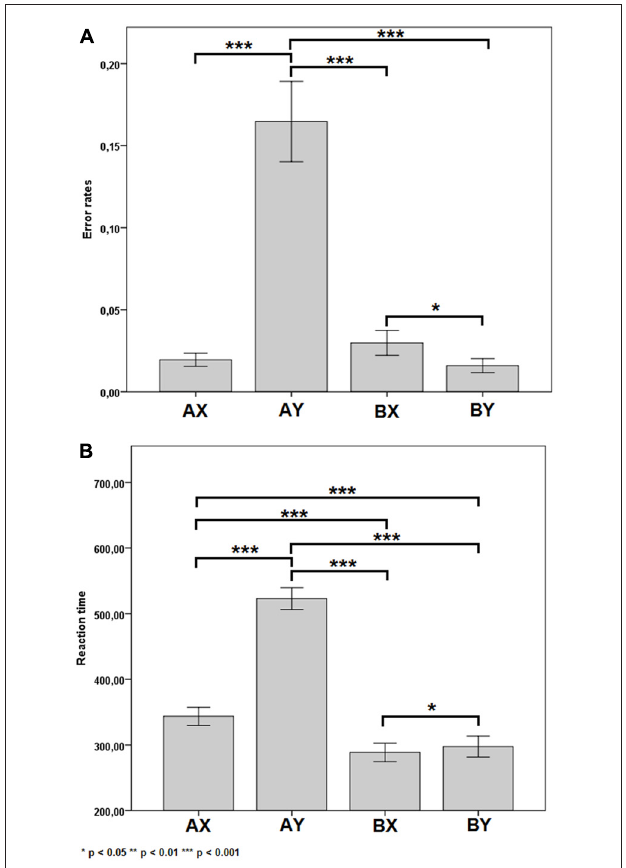
FIGURE 2 | Error rates (A) and reaction time (B) for each of the four sequences. Error bars represent one standard error of the mean.